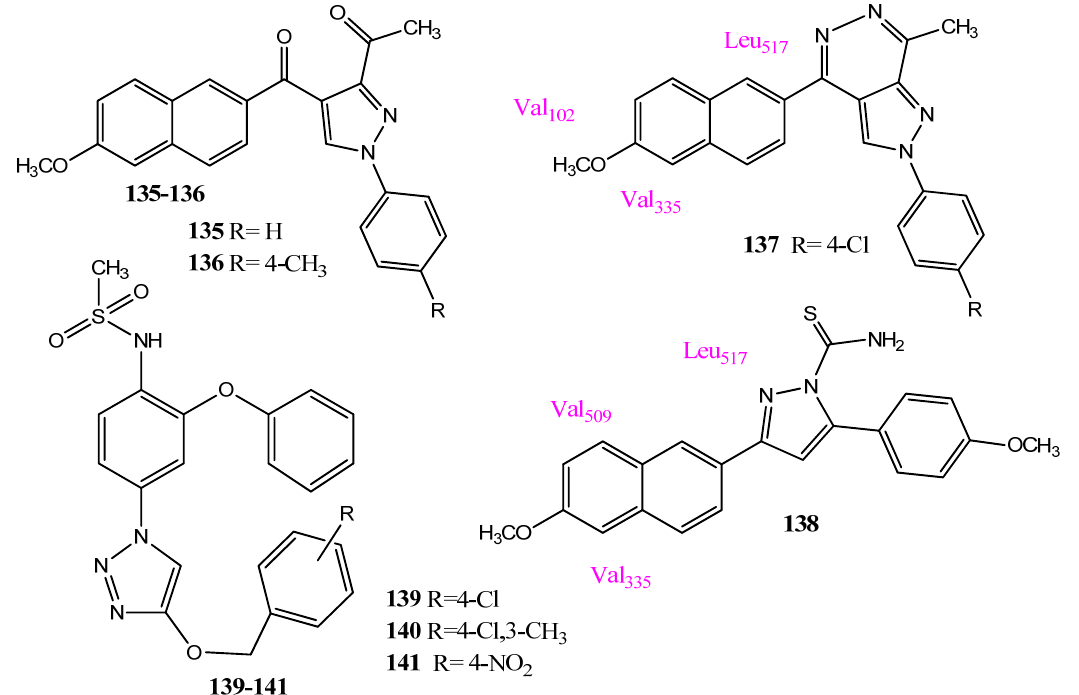
Figure 27. Naproxen and nimesulide derivatives.